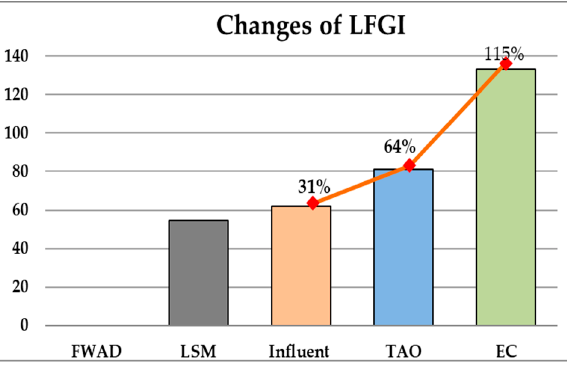
Figure 4. Maturity of the effluent as measured using the LFGI. Table 5. Seed GI for the manure samples before and after TAO and EC treatment.